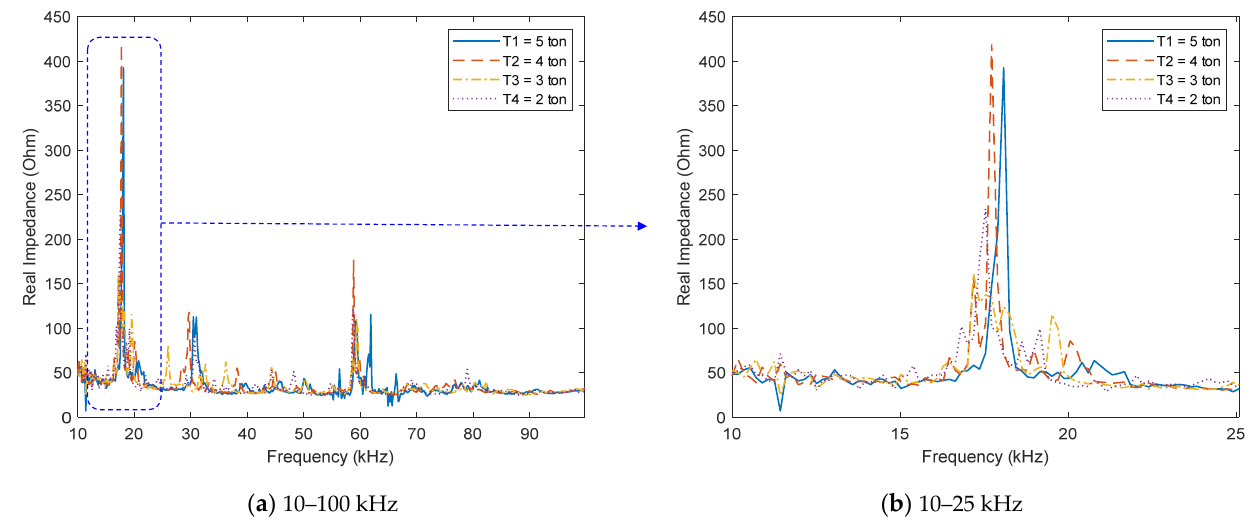
Figure 10. Real electromechanical impedance responses of the washer-type PZT interface.